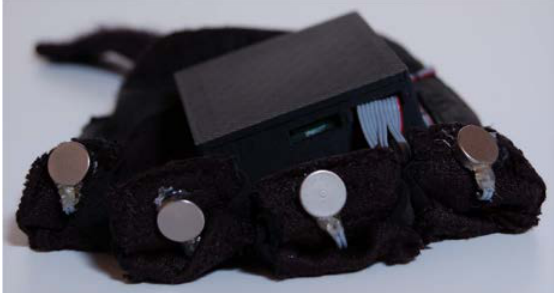
Fig. 3. MMT Glove with Vibration Motors by Precision Microdrives exposed.